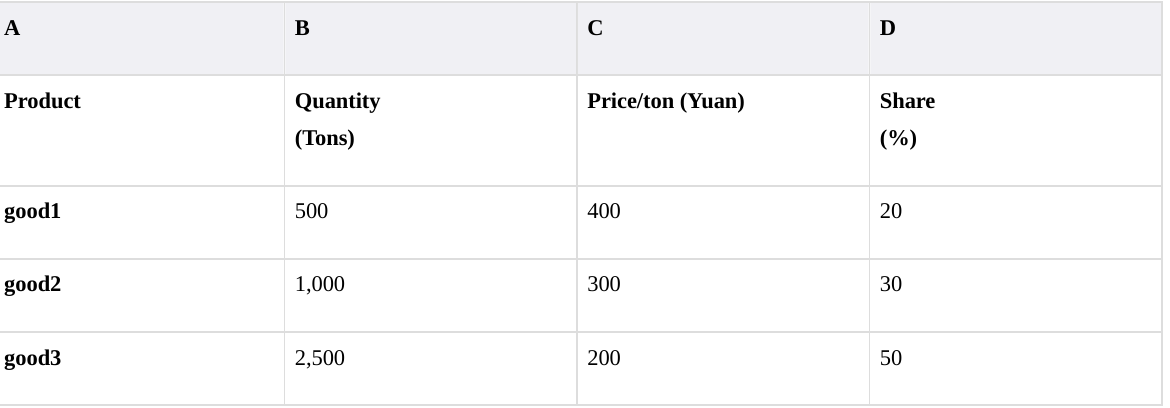
Table 1. An Economy with three types of products (Wang 1955, p.